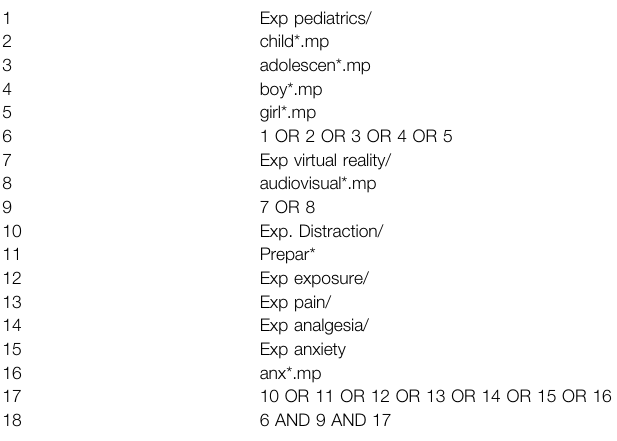
TABLE 1 | Search strategy for the PsycINFO